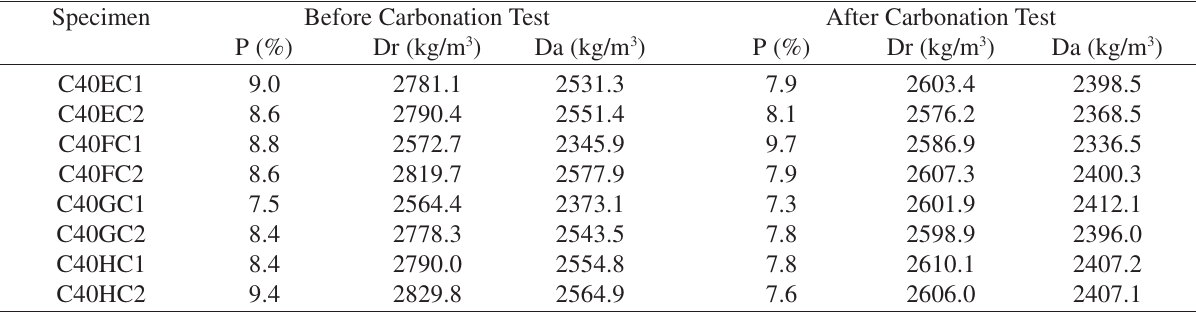
Table 6. Porosity Accessible to Water, Before and After Carbonation Test.